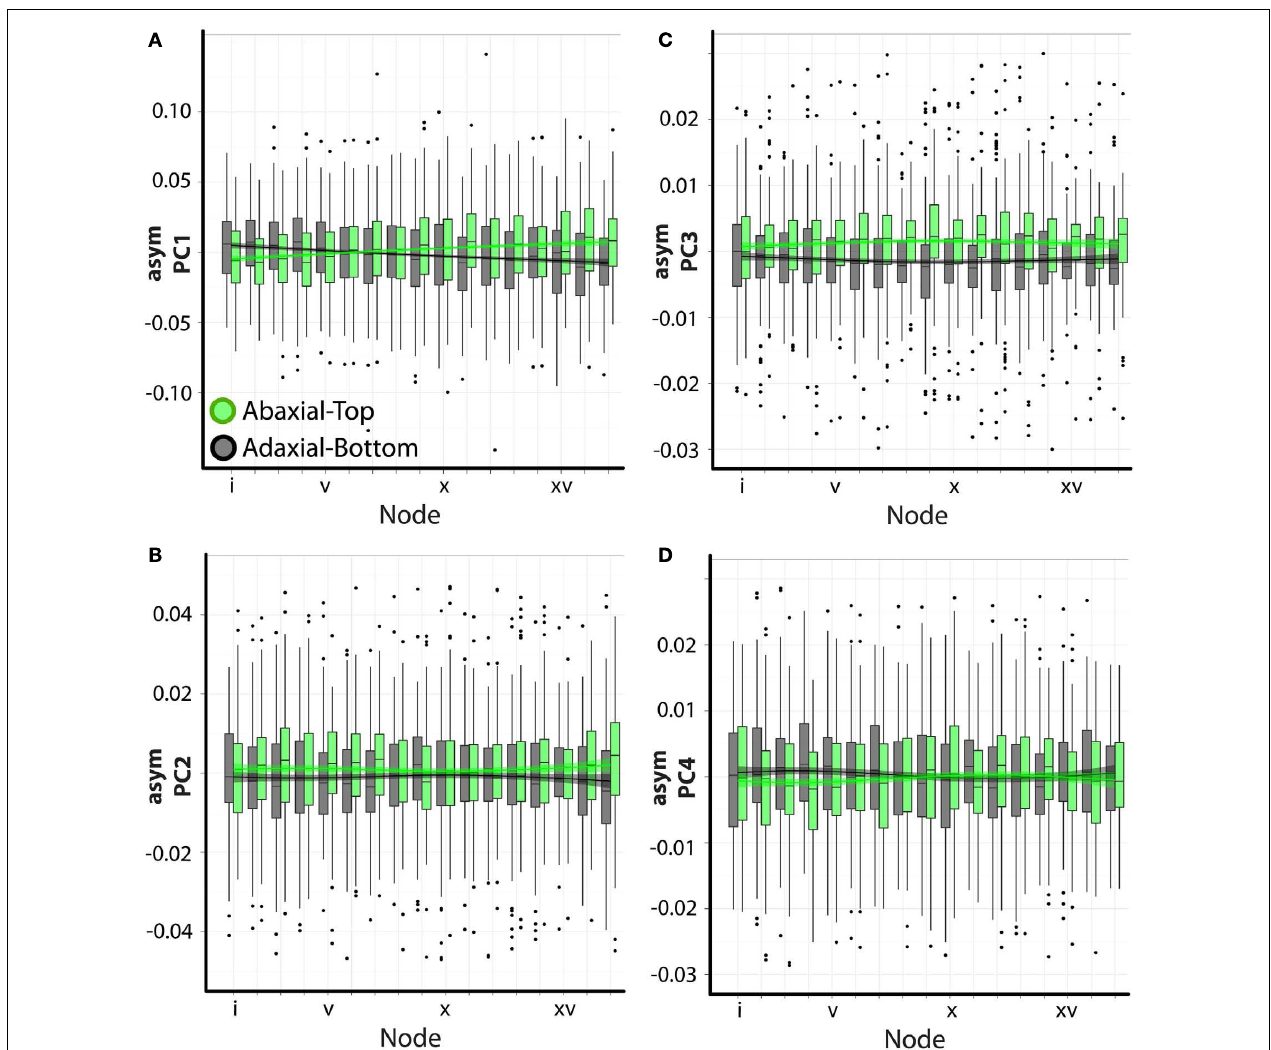
significant differences in PC values between abaxial-top and adaxial-bottom outlines for PCs 1–4, signifying intrinsic asymmetry, are easily observed. Additionally, various types of interactions between the abaxial-top/adaxial-bottom factor with node position are present, denoting that intrinsic asymmetry changes through the leaf